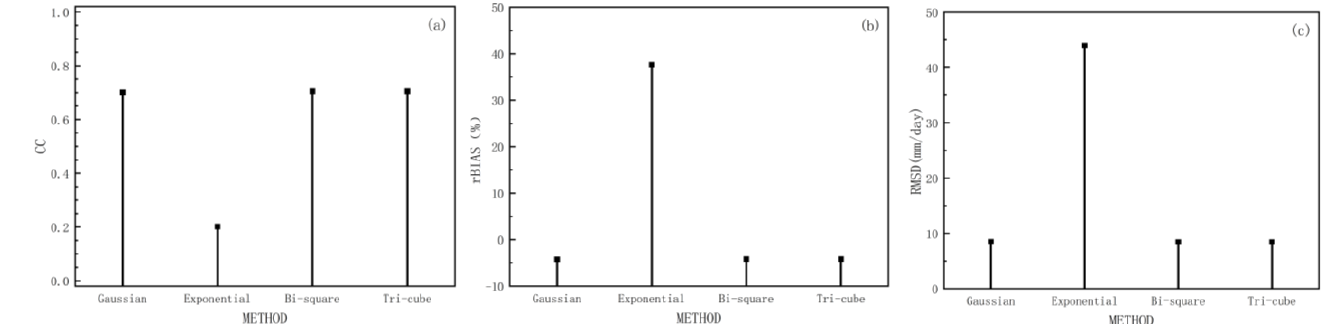
Figure 6. Cross-validation continuous statistics ( a ) CC, ( b ) rBIAS, and ( c ) RMSD on daily combined precipitation data using four weighting functions (Gaussian, exponential, bi-square, and tri-cube).